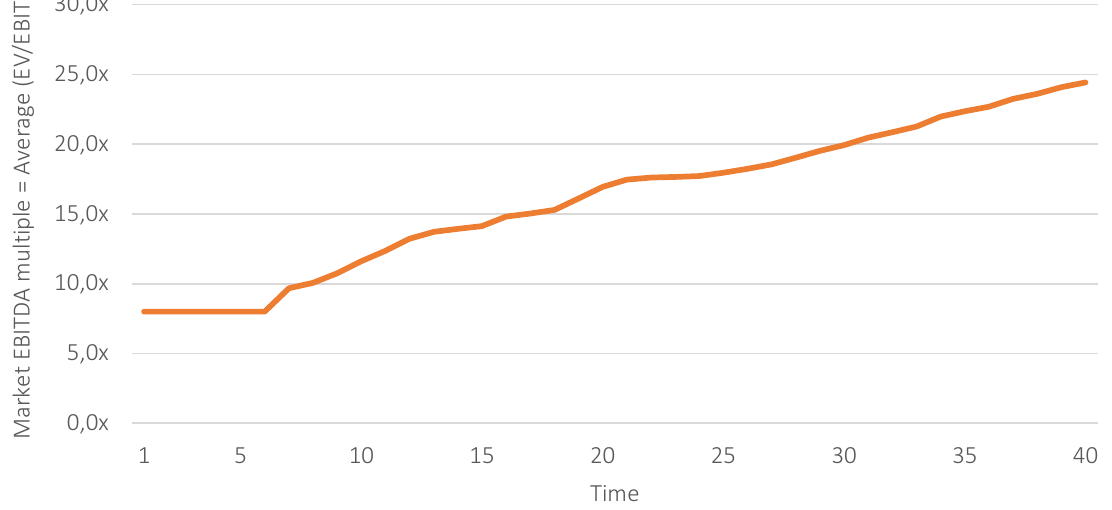
Figure 8. Market ebitda multiple evolution in a conventional LBO